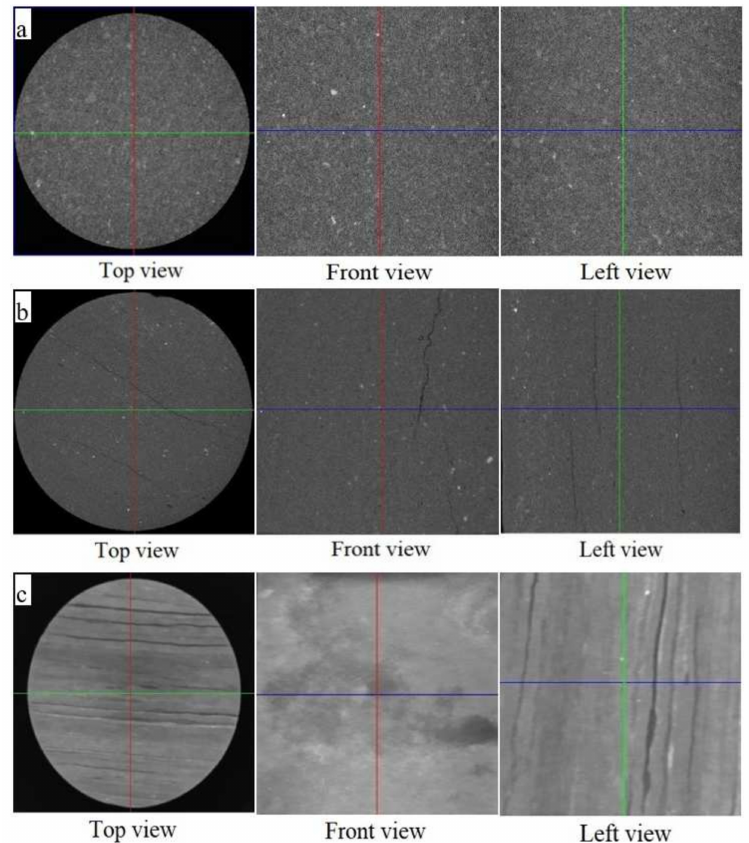
Figure 10. CT scanning images of the lamellar shale samples: ( a ) the dry lamellar shale sample; ( b ) the 48-h hydration lamellar shale sample; ( c ) the 48-h hydration lamellar shale sample after triaxial compression test under the confining pressure of 30